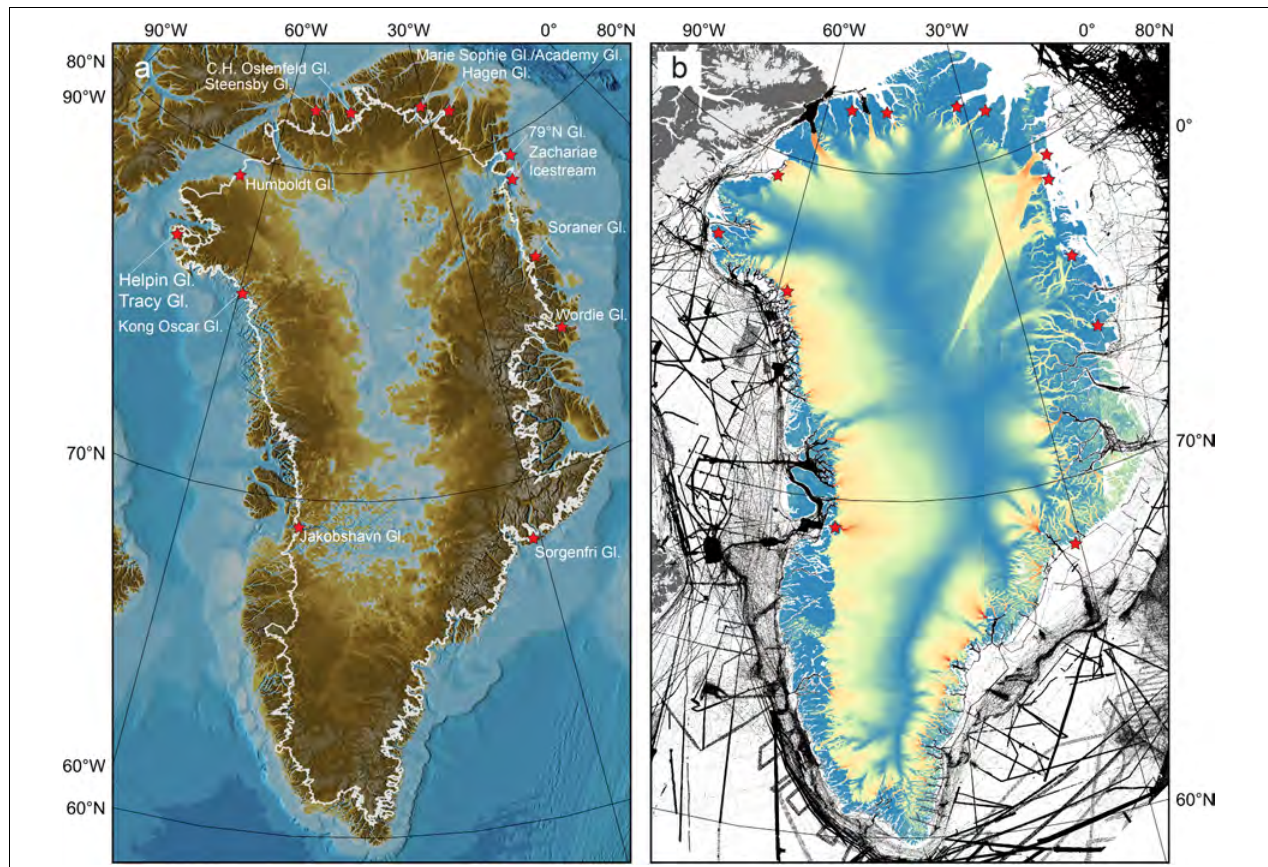
FIGURE 6 | (a) Marine outlet glaciers with poor to no depth data coverage in their hosting fjords. (b) Bathymetric data around Greenland in the IBCAO 4.1